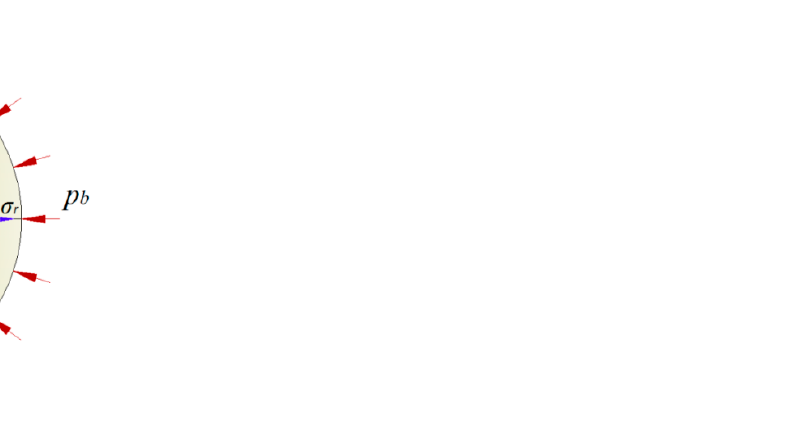
Figure 1. Model of a single layer pipe established for the calculations, where p a —internal pressure, p b —external pressure, r a —internal radius, r b —external radius and ρ —concentric surface radius. After determining the integration constants for the equilibrium differential The relationship between the stresses and the strains in a plane stress state is described by the following constitutive equations: